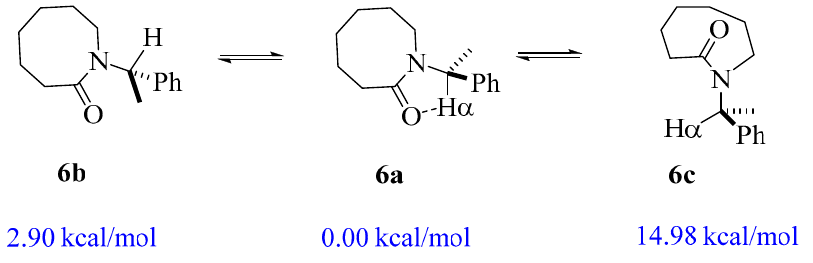
Figure 3. Observed conformers of lactam 6, and their relative energies.